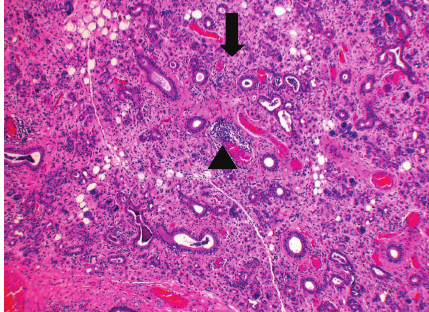
Figure 3: Partial-amifostine (HE, Original magnification × 28). Submandibular gland with partial-amifostine treatment reveals interstitial fibrosis (white arrow), scattered acinar remnants (arrow- head), and intact ductal remnants (black arrow).